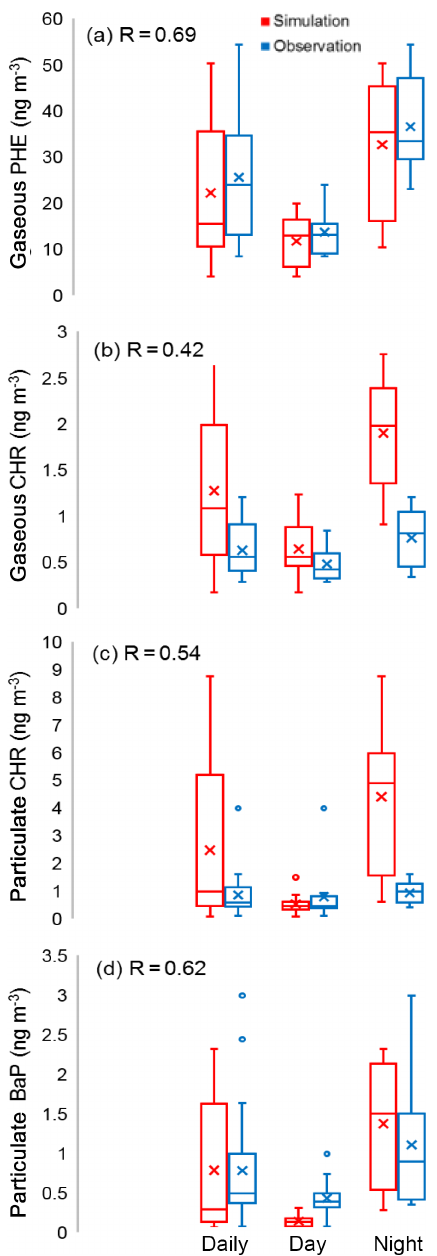
Figure 3. Simulated (red) and observed (blue) concentrations of (a) gaseous PHE, (b) gaseous CHR, (c) particulate CHR and (d) particulate BaP at the Xianghe site averaged over 11– 22 July 2013. The line and “X” in each box are the median and mean, while the boxes represent the 25th and 75th percentiles. Up- per whisker is quartile 3 (Q3) + 1.5 × interquartile range (IQR) or maximum value, whichever is smaller; lower whisker is quartile 1 (Q1) − 1.5 × IQR or minimum value, whichever is larger. The Spearman’s rank correlation coefficients R use combined daytime and nighttime data